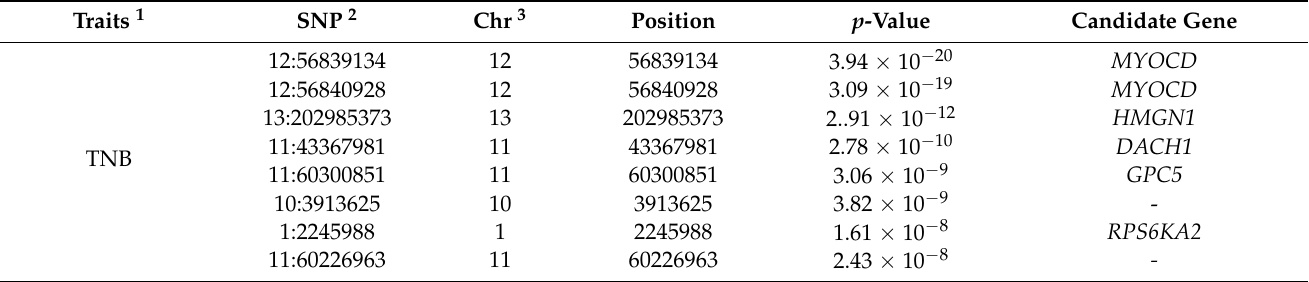
Figure 3. Manhattan and Q-Q plots of GWAS based on data imputation with SWIM for five repro- ductive traits. ( A ) The red line represents the genome-wide significance level (4.90 × 10 − 8 ). The blue line represents the suggestive significance (9.81 × 10 − 7 ). ( B ) Q-Q plots of five reproductive traits. Abbreviations: GL = gestation length, LBW = litter birth weight, NBA = number born alive, NW = number of weaned, TNB = total number born. Table 6. The significant SNPs in the genome for the total number born (TNB) and gestation length (GL) traits using data imputed with